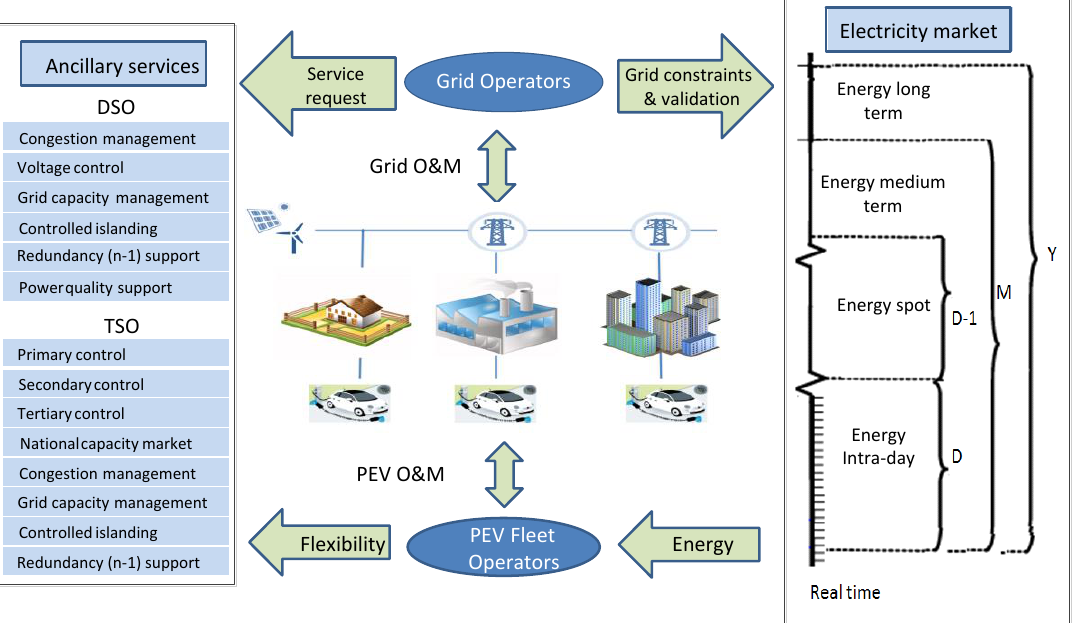
Figure 1. A schematic overview of integration and management of plug-in electric vehicles (PEVs) in a market-based environment.